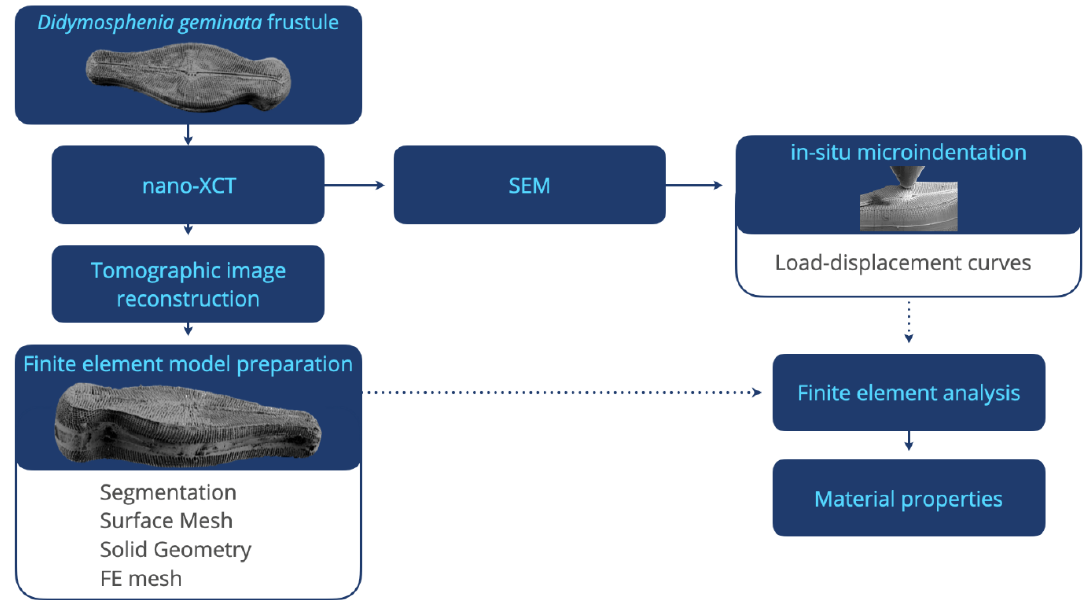
Figure 1. The methodological workflow used to extract material properties of Didymosphenia geminata frustule.